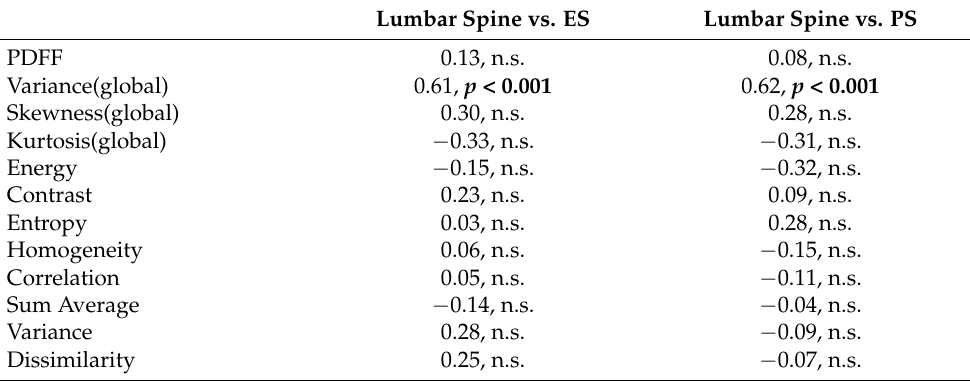
Table 2. Partial correlation analysis between PDFF and texture features of the lumbar spine and the corresponding features in the erector spinae muscle (ES) or the psoas muscle (PS) respectively, adjusted for BMI and